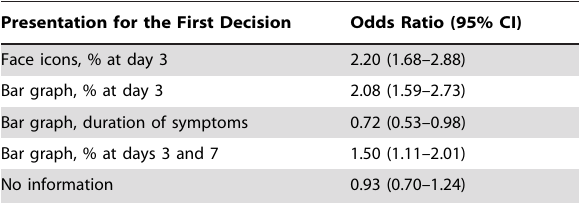
Table 4. Comparisons of the presentation groups. Presentation